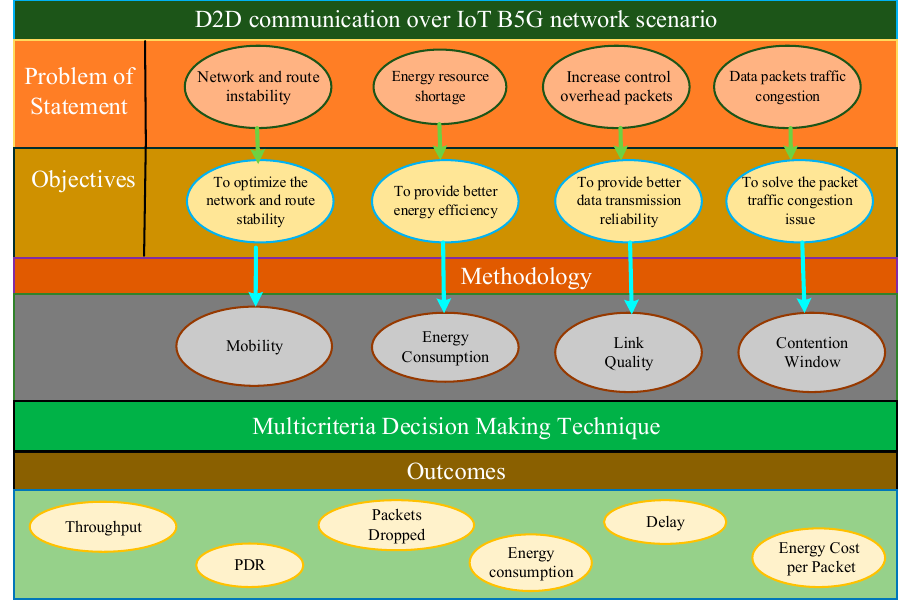
Figure 3. Challenges and solutions of MBLCR scheme.